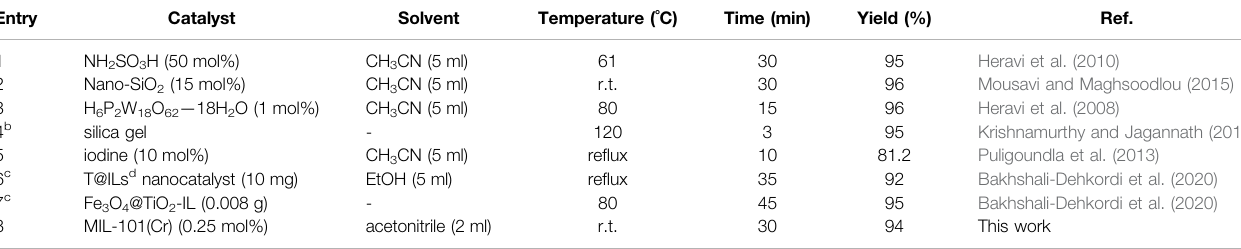
TABLE 3 | The comparison between this catalytic system and previously reported catalytic systems a